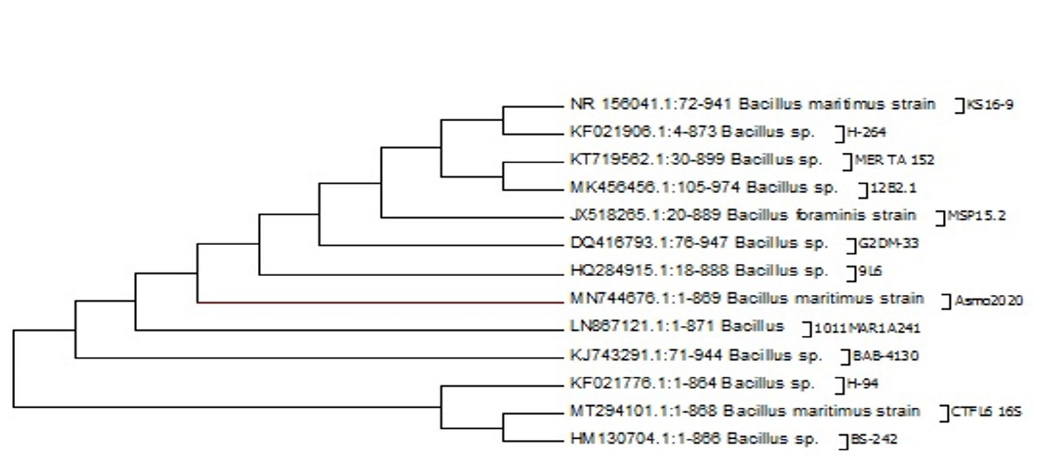
Fig. 1. Molecular Phylogenetic analysis by Maximum Likelihood method of Bacillus Maritimus strain Asmo2020 in gene